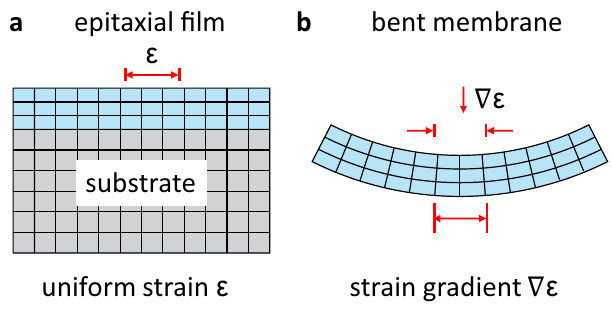
Fig. 1 Modes of strain accessible to epitaxial fi lms vs free-standing membranes. a Piezomagnetism and magnetostriction are magnetic responses to uniform strain ( ϵ ) and are accessible in thin fi lms. b Flexomagnetism is the response to strain gradients ( ∇ ϵ ) and is accessible in ultrathin membranes.